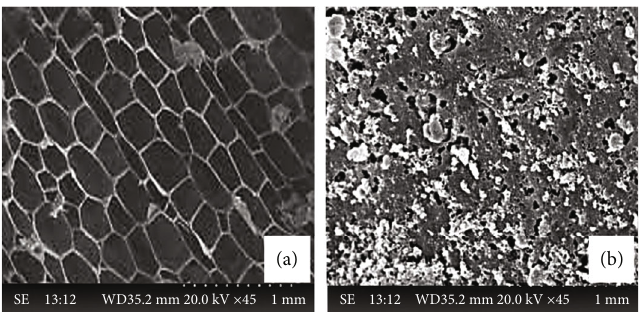
Figure 9: Microstructural images of (a) pure hemp and (b) activated carbon-based